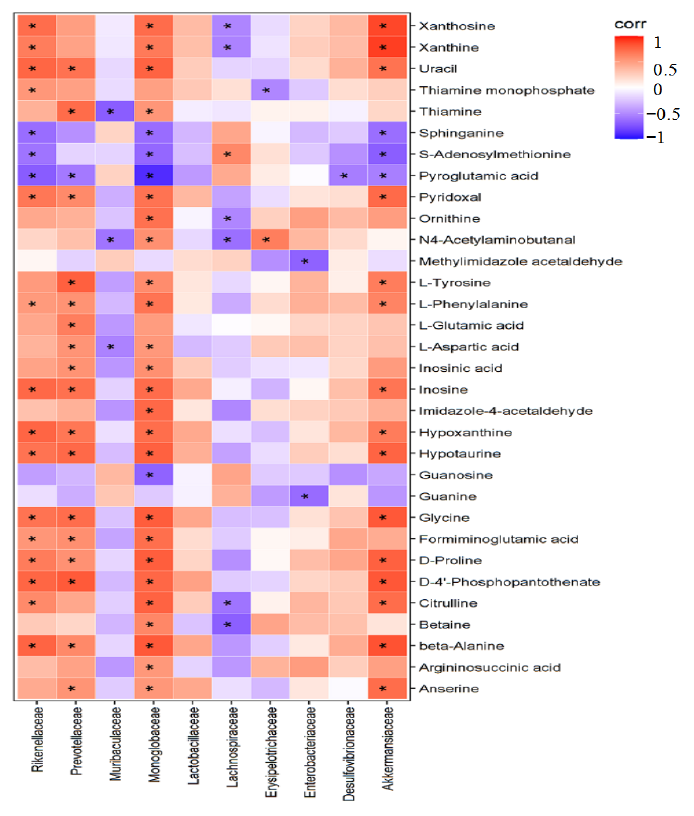
Figure 11. Spearman correlation heatmap of differentially expressed microflora and serum metabo- lites,* p < 0.05.